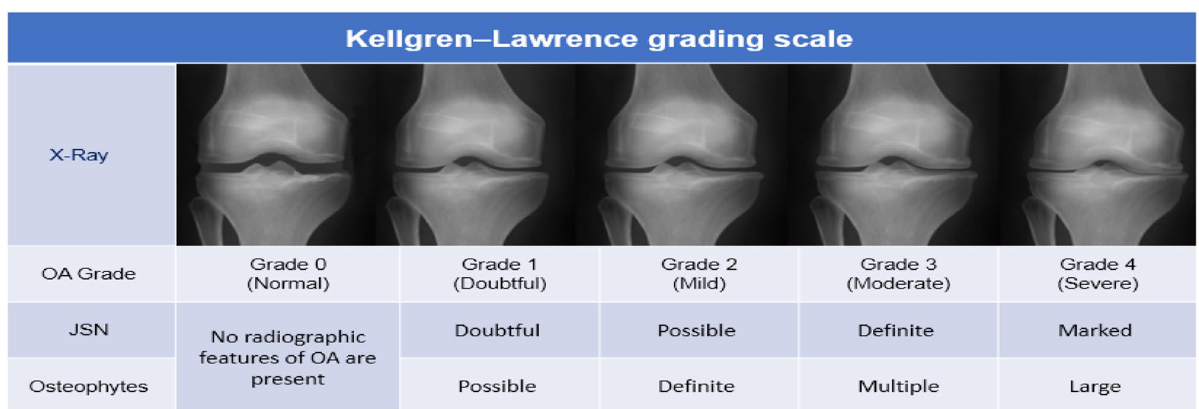
Figure 2. KL starts with KL = 0 representing normal and KL = 4 representing most severe cases of